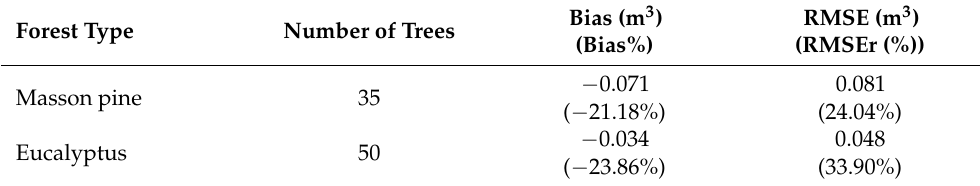
Table 6. Comparison of single-tree volumes based on different allometric equations. Forest